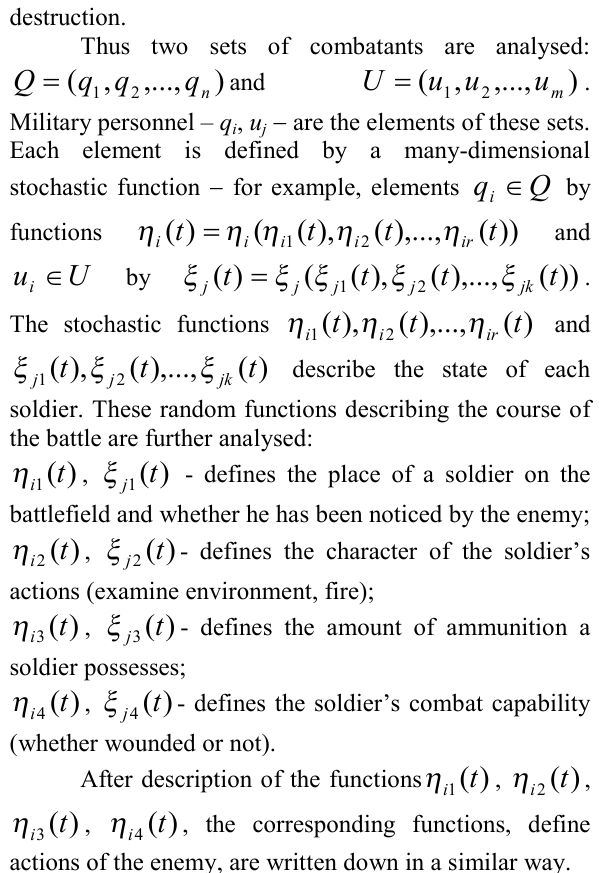
and three soldiers operate a grenade launcher . Area is the position of the fortified